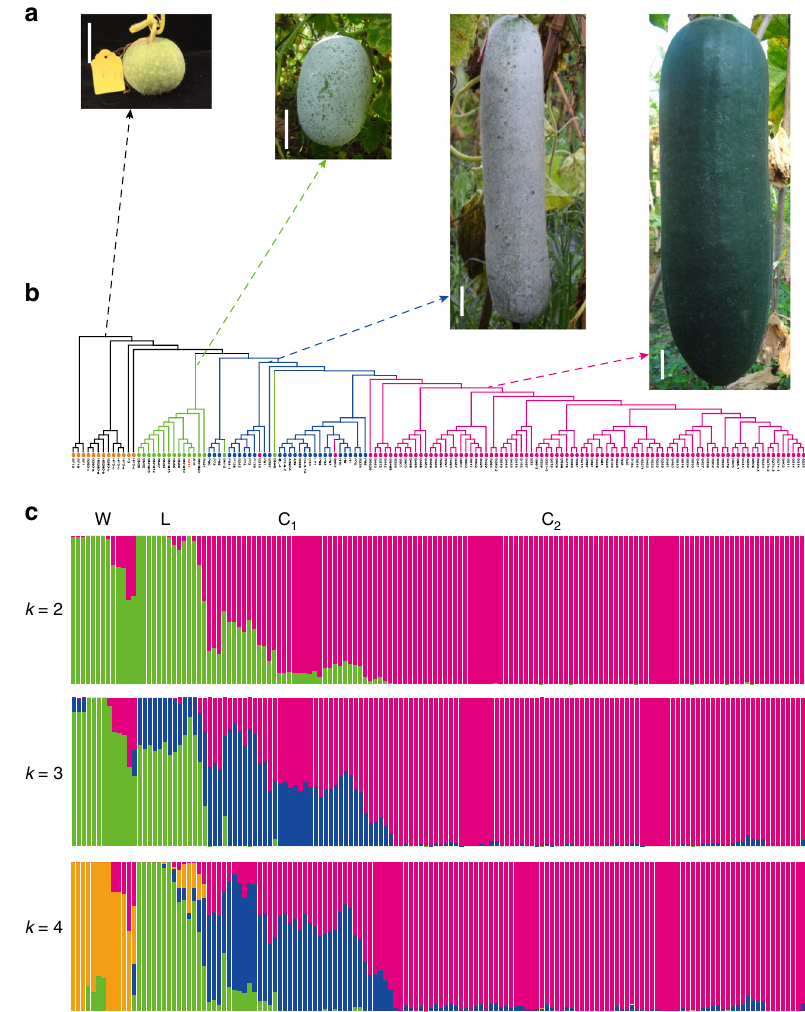
Fig. 4 Population structure of 146 wax gourd accessions. a Fruit morphology of the four groups. Bar is 5 cm. b Neighbor-joining phylogenetic tree constructed using SNPs at fourfold-degenerate sites. Wild group (W) contains wide accessions from India, Japan, and China (orange); accessions of Landrace group (L) are mainly form Xishuangbanna region of China (green). Two cultivated groups contain accessions bearing large fruit, with group C1 (blue) being covered by wax, but not in group C2 (magenta). c Model-based clustering analysis with different cluster numbers ( k = 2, 3, and 4). The y -axis quanti fi es cluster membership, and the x -axis lists the different accessions. The orders and positions of these accessions on the x -axis are consistent with those in the neighbor-joining tree. The source data underlying b and c are provided as a Source Data fi (Fig. 5c). In cucumber, its ortholog Csa2G258100 is also signi fi cantly up-regulated in long-fruited line 24 (Supplementary Fig. 14), and was mapped in the quantitative trait locus (QTL)